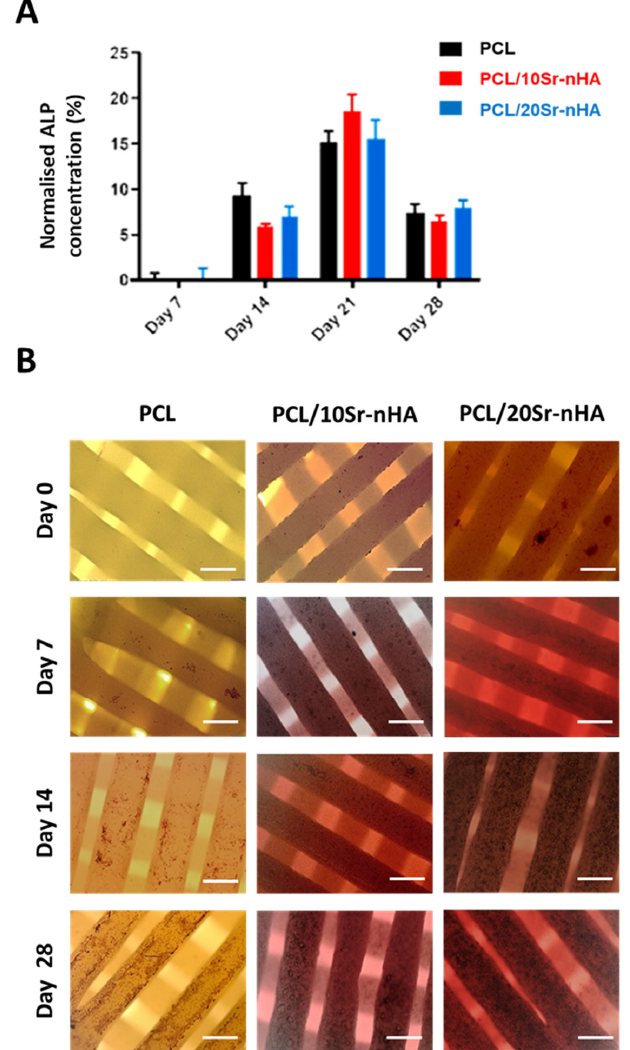
Figure 10. ( A ) Normalized ALP activity of the PCL, PCL/10Sr-nHA and PCL/20Sr-nHA samples up to 28 days in culture with U2OS cells (data are presented as mean ± standard deviation. n = 6) and ( B ) optical microscopy images of cell-seeded scaffolds showing calcified nodules stained with Alizarin red after 0, 7, 14 and 28 days (scale bar = 400 μ m).